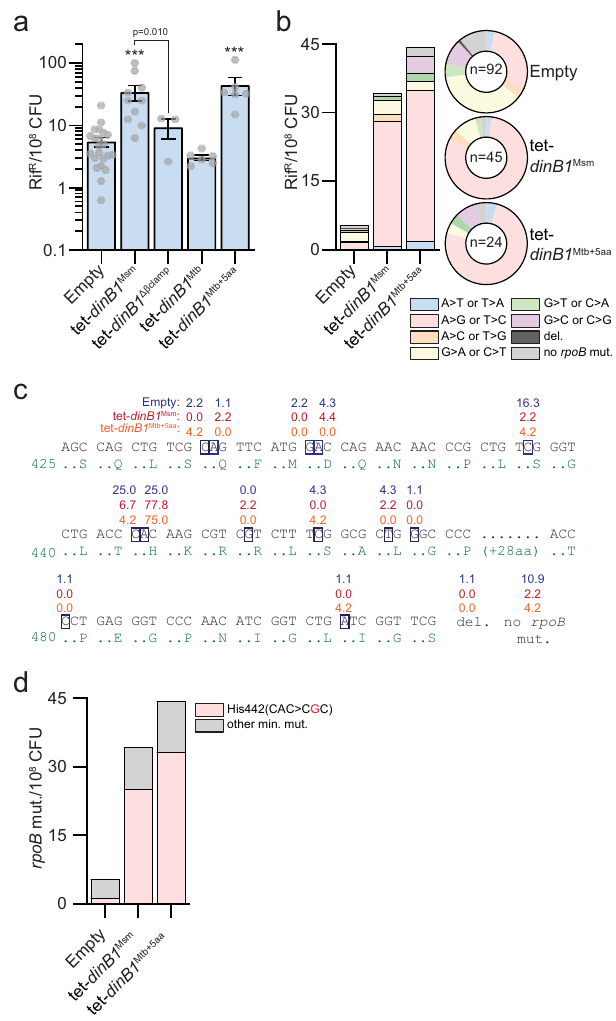
Fig. 2 | DinB1 is an error-prone polymerase inducing antibiotic resistance through a characteristic mutagenic signature. a Rifampicin resistance (rif R ) frequency in indicated strains in presence of inducer. Results shown are means (±SEM) of data obtained from biological replicates symbolized by gray dots. Stars abovebarsmarkastatisticaldifferencewiththereferencestrain(emptyvector)and lines connecting two strains show a statistical difference between them (***, P <0.001). p-values were obtained on log-transformed data by one-way ANOVA with a Bonferroni post-test. b Relative (pie chart) and absolute (bar chart) fre- quencies of nucleotide changes detected in rpoB of rif R clones from the indicated strains. The number of sequenced rif R is given in the center of each pie chart. c Location and relative frequency in % of mutated nucleotides in rpoB found in empty (blue), tet- dinB1 Msm (red) or tet- dinB1 Mtb+5aa (orange) rif R . d Absolute fre- quency of the main rpoB mutations found in indicated